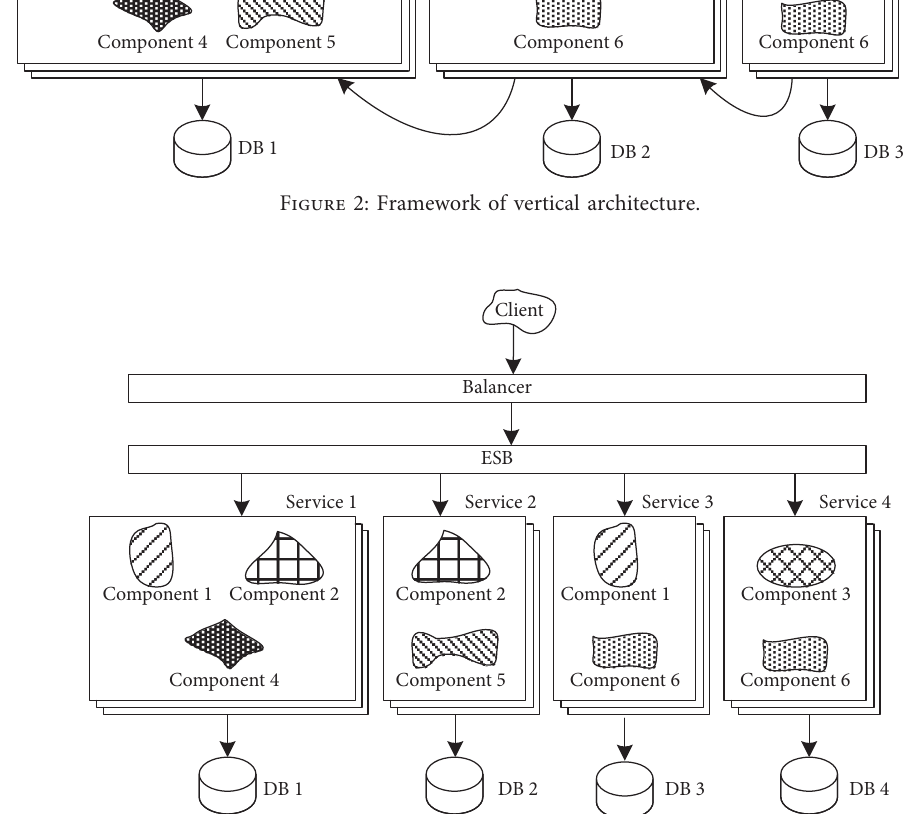
Figure 3: Framework of service-oriented architecture.